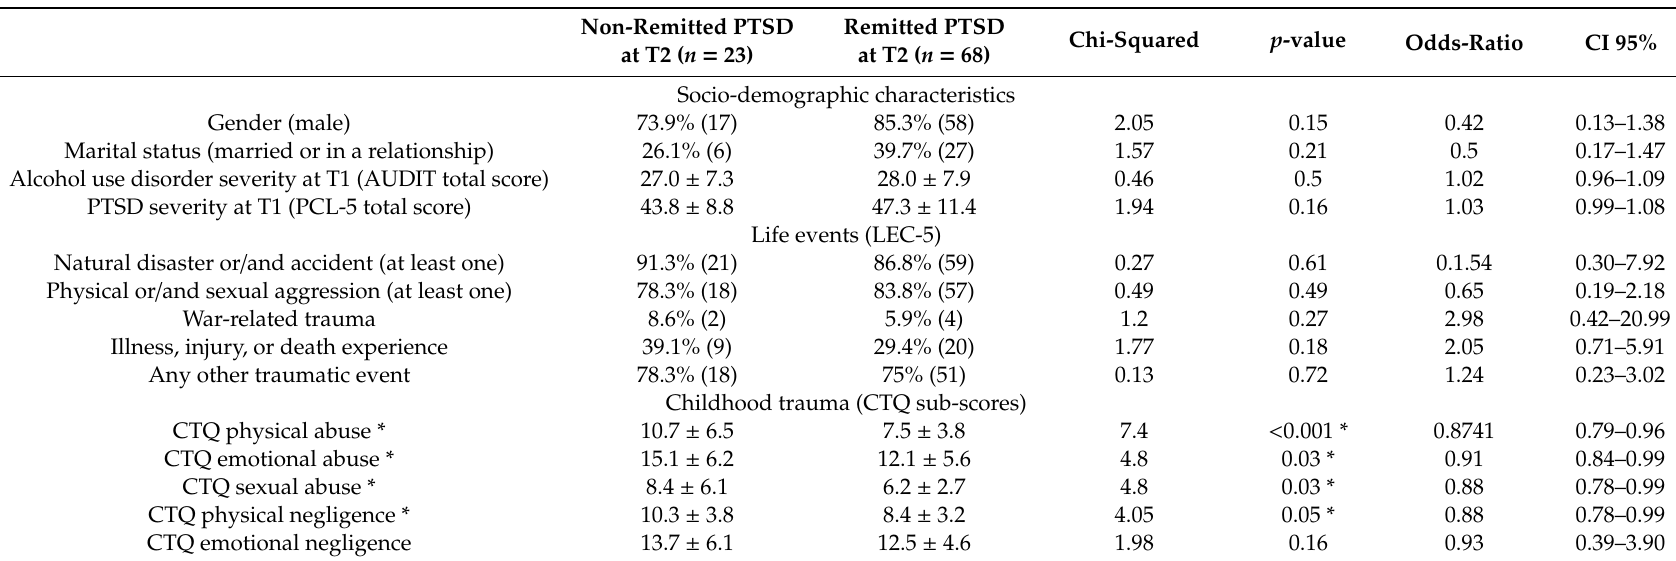
Table 3. Baseline T1 characteristics associated with PTSD remission at T2 in multiple logistic regressions after adjustment for